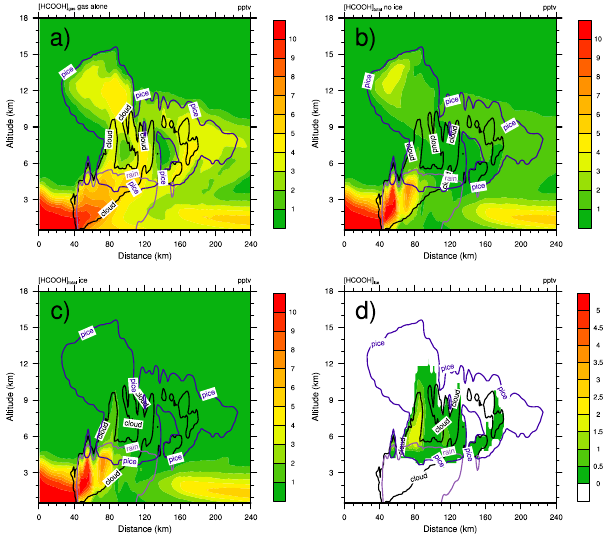
Figure 9. COPT case: same as Figure 7 but for formic acid. 2 Fig. 9. COPT case – same as Fig. 7 but for formic